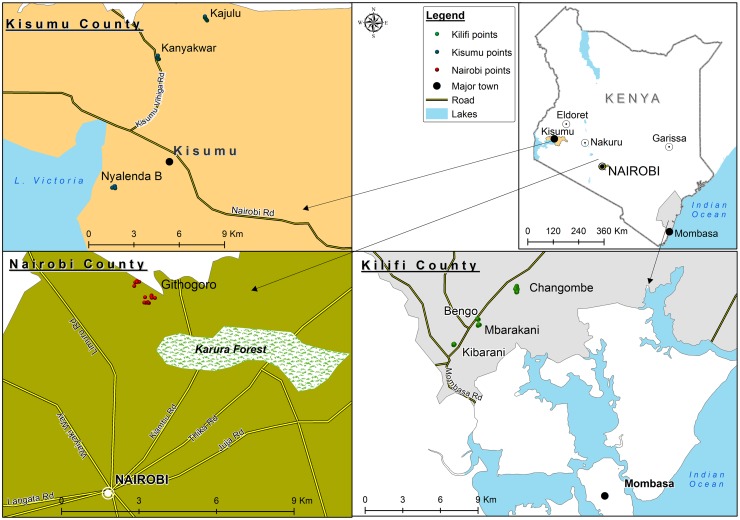
Map indicating the study sites within Kilifi, Kisumu, and Nairobi Counties of Kenya.